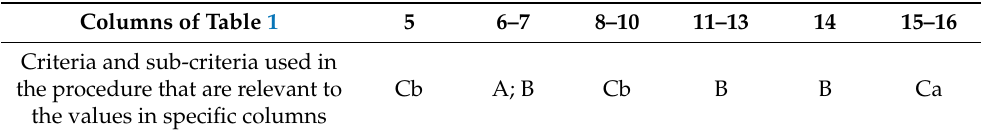
Table 2. Connection between the values given in individual columns of Table 1 and the procedure described